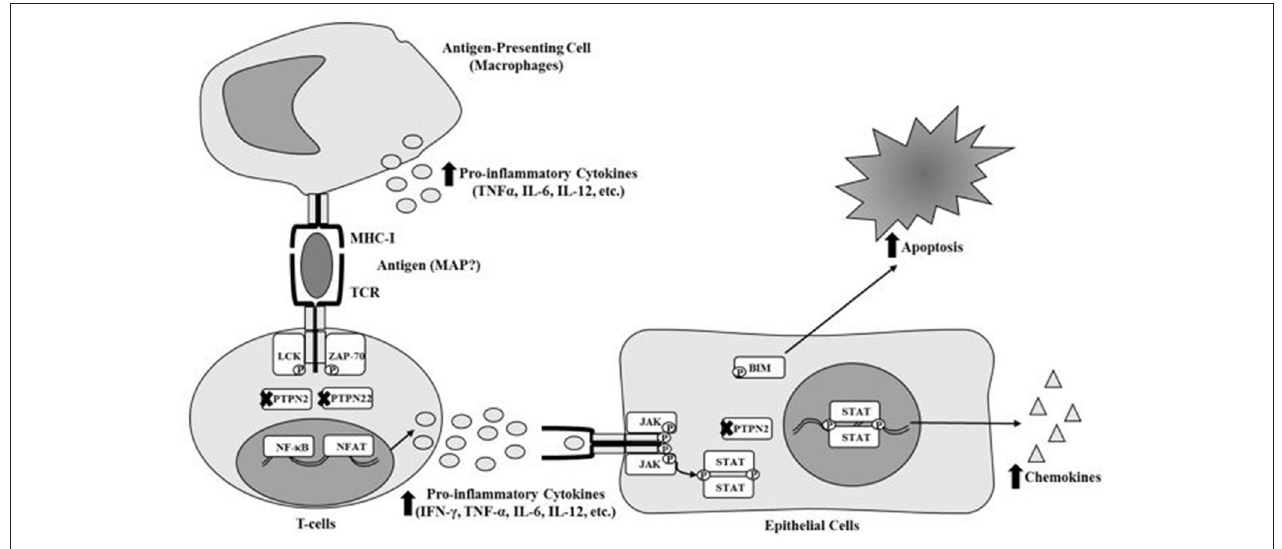
FIGURE 1 | Effect of SNPs in PTPN2/22 on T-cell